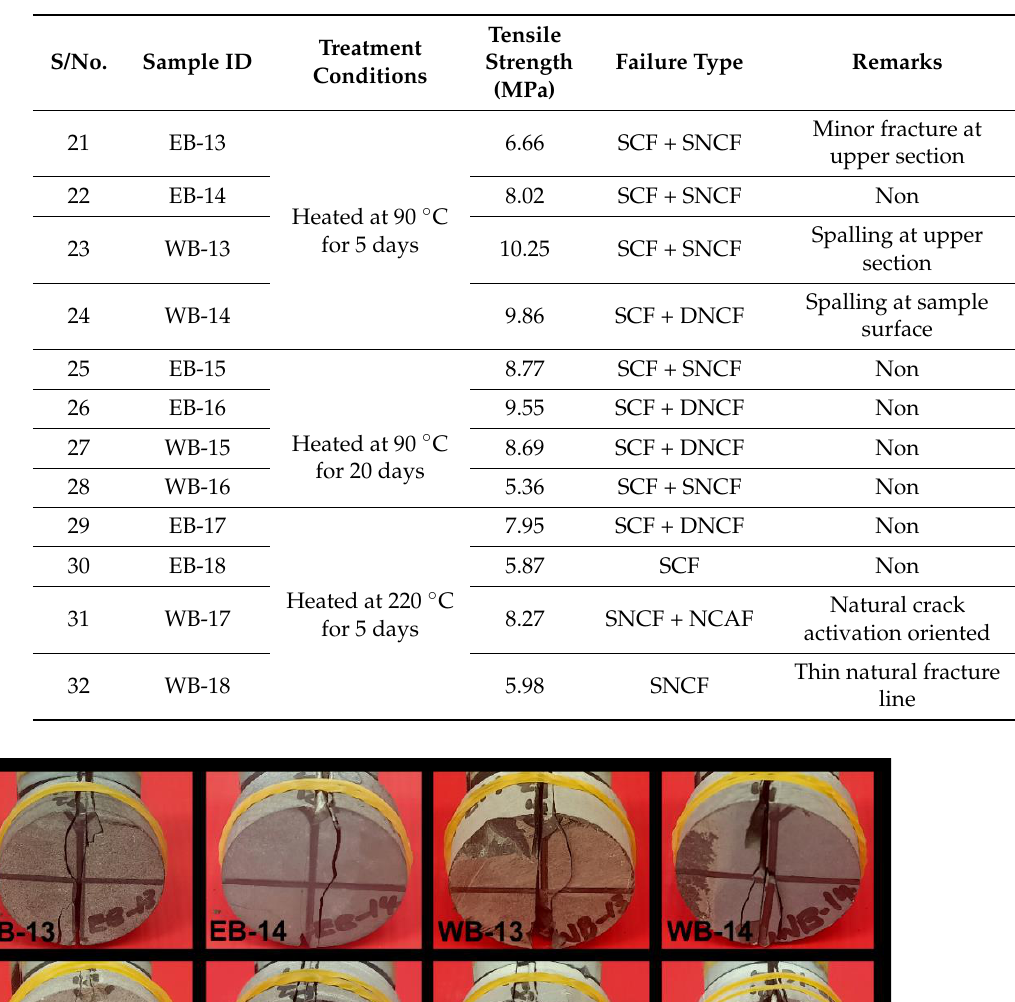
Table 3. Tensile failure classifications for samples subjected to reservoir temperature controlled con- ditions of 90 °C for 5 and 20 days and 220 °C for 5 days prior to BITS testing. Identified failure patterns included SCF, SNCF, DNCF, and NCAF.